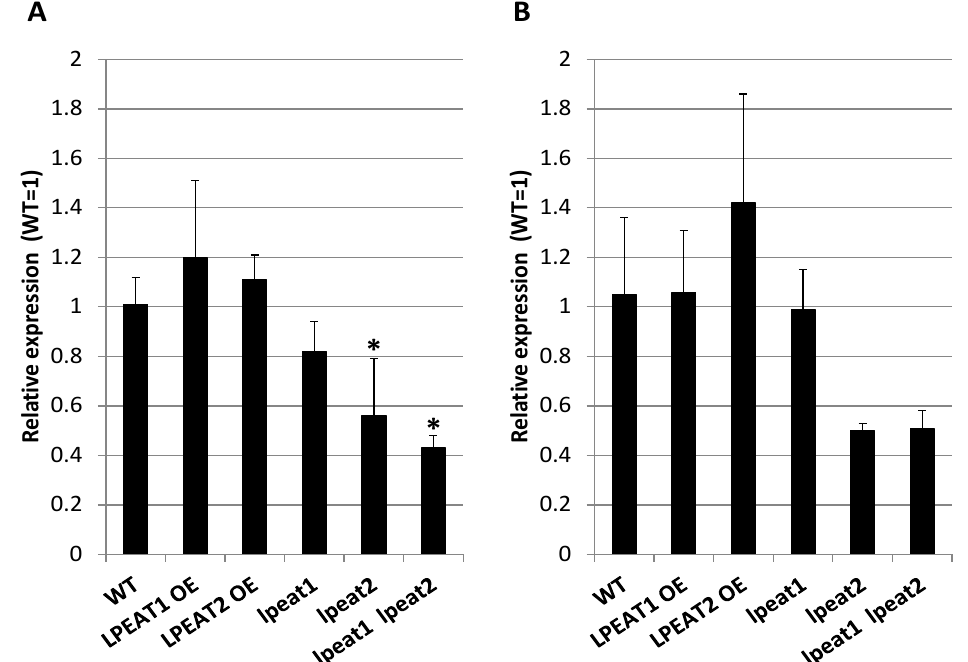
Figure 6. ATG8a gene expression analysis between different Arabidopsis thaliana lines. ATG8a transcript level in LPEAT1 and LPEAT2 overexpressors as well as in lpeat1 mutant, lpeat2 mutant and lpeat1 lpeat2 double mutant is displayed as relative to this gene’s expression level in wild-type (WT) with the assigned value of 1. The EF1ALPHA ( A ) and ACT2 ( B ) gene expression was treated as reference in qRT-PCR. Means ± SD are presented (n = 3). Asterisk indicates significant difference compared with WT in “mean difference two sided test” at α = 0.05.